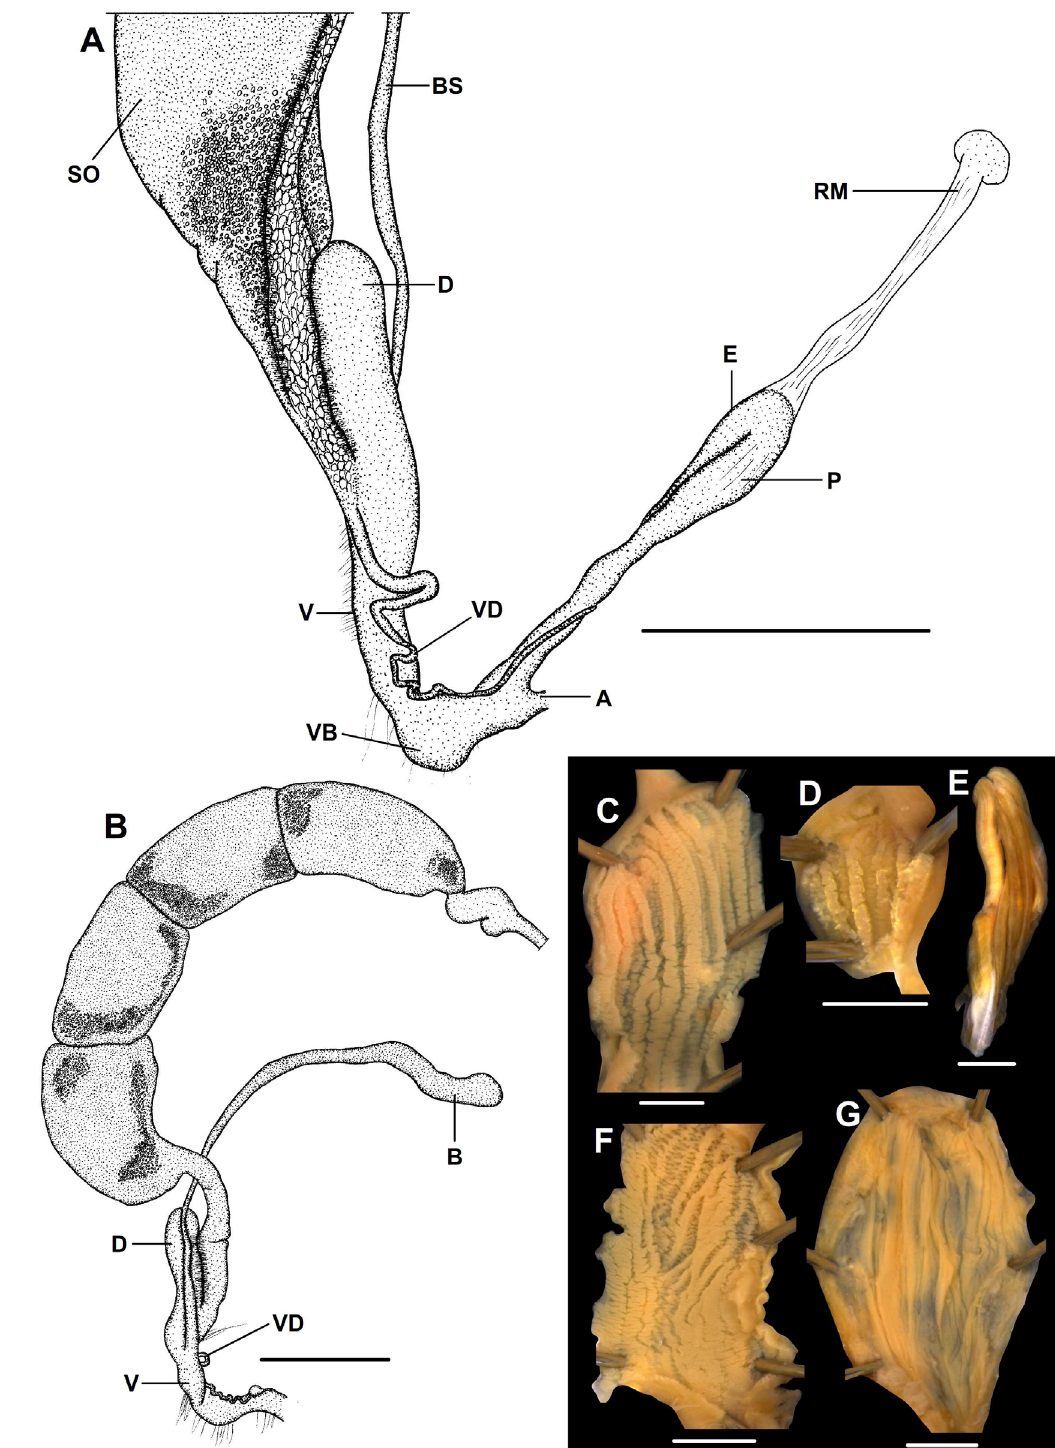
Fig. 47. Genitalia of Plectopylis thompsoni sp. nov. A . Distal genitalia, PL070 (UF 76482). B . Genitalia of an aphallic specimen, PL069 (UF 76482). C–D, F–G . Inner structure of genital organs (C = penis, D = epiphallus, F = vagina, G = diverticulum), PL070 (UF 76482). E . Spermatophore, PL070 (UF 76482). Scale bars: A–B = 5 mm; C–G = 1 mm. For abbreviations see Fig. 2. All photos: B.